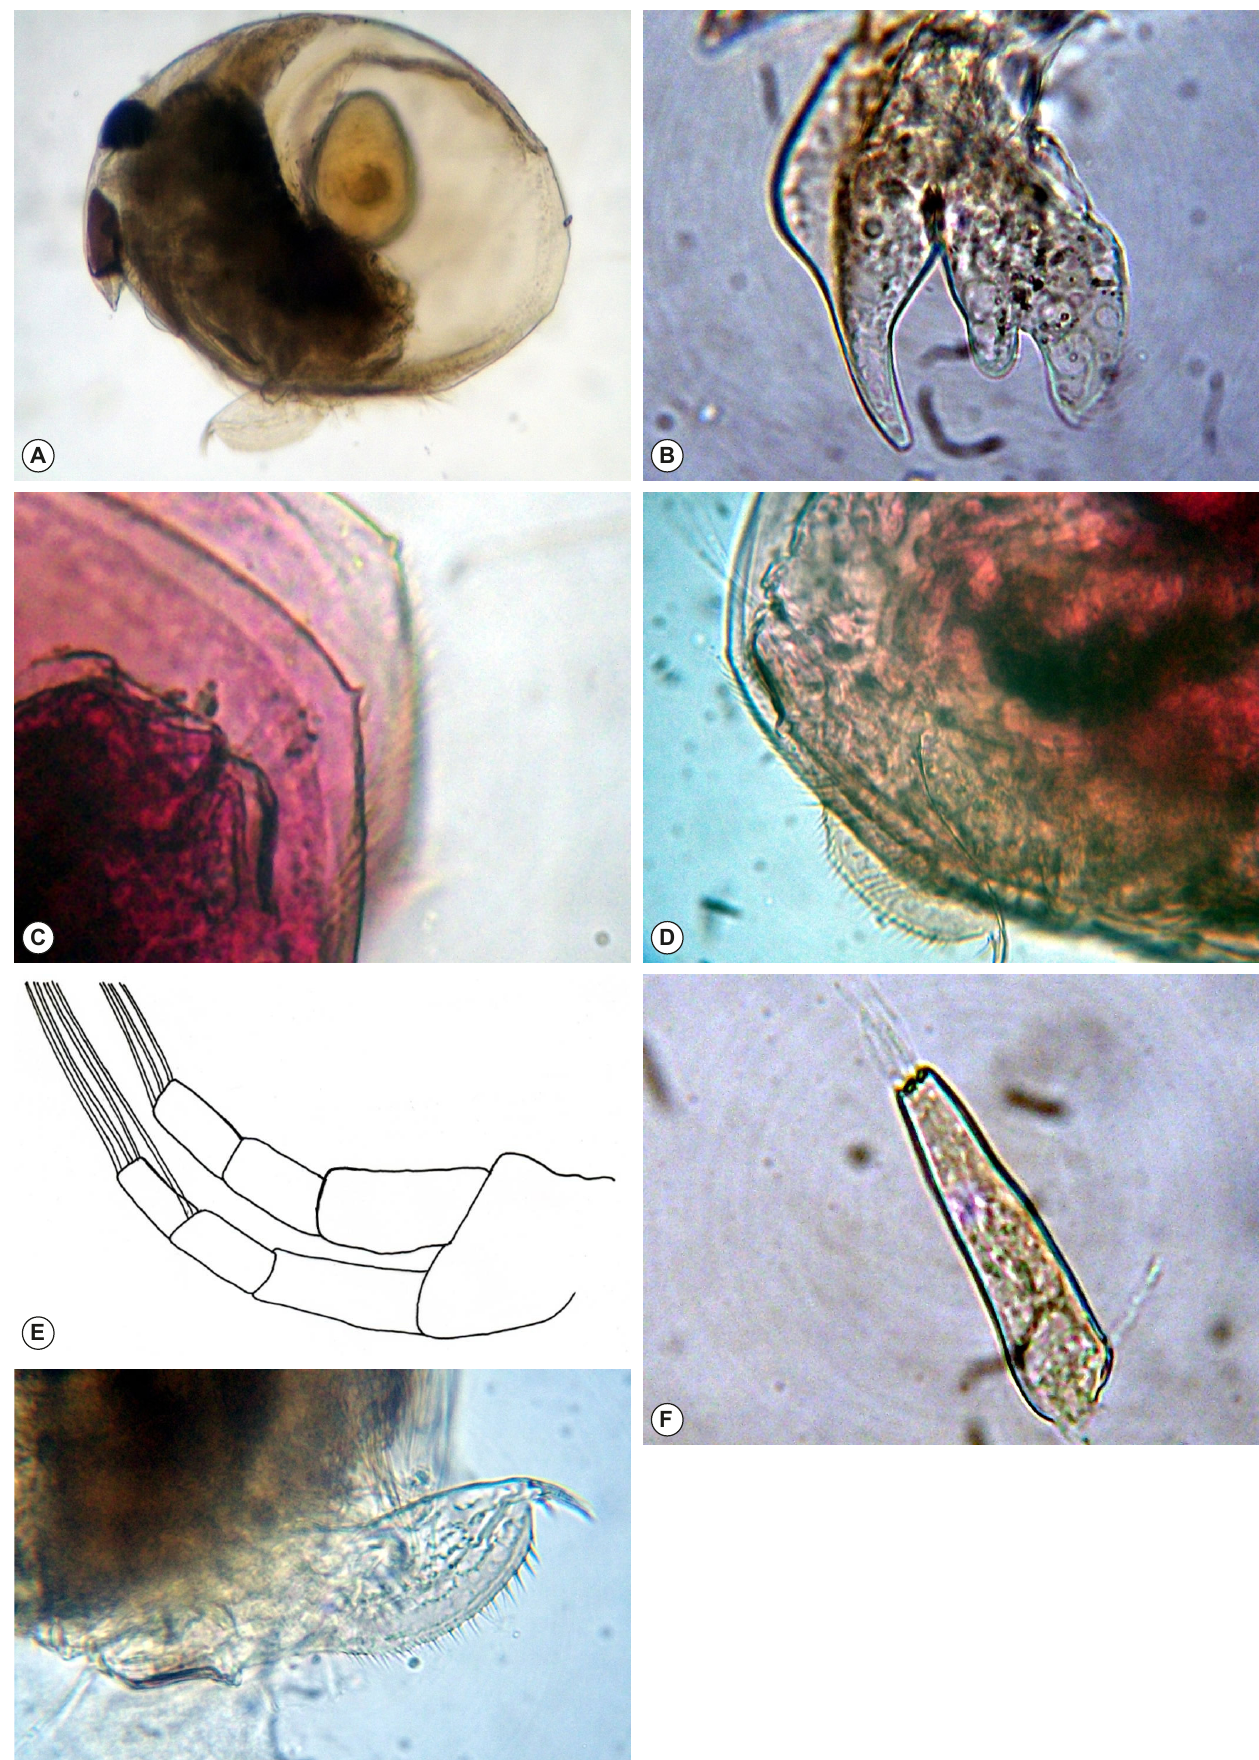
Figure 6. Dadaya